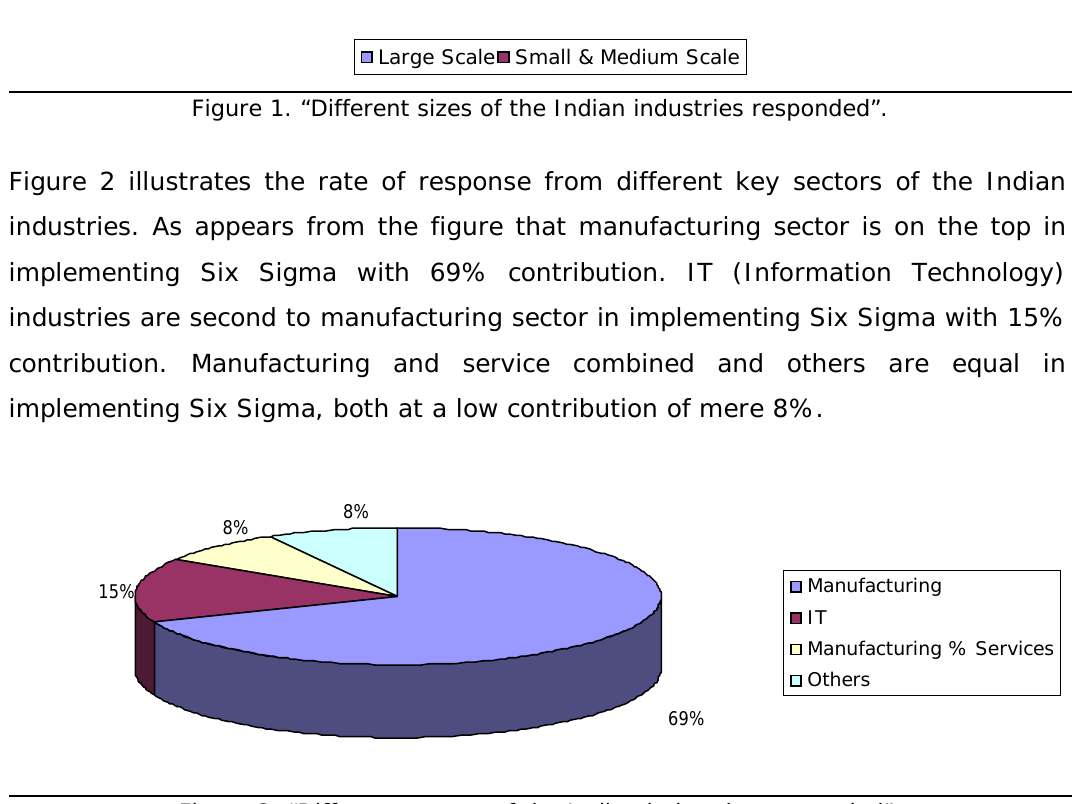
Figure 2. “Different sectors of the Indian industries